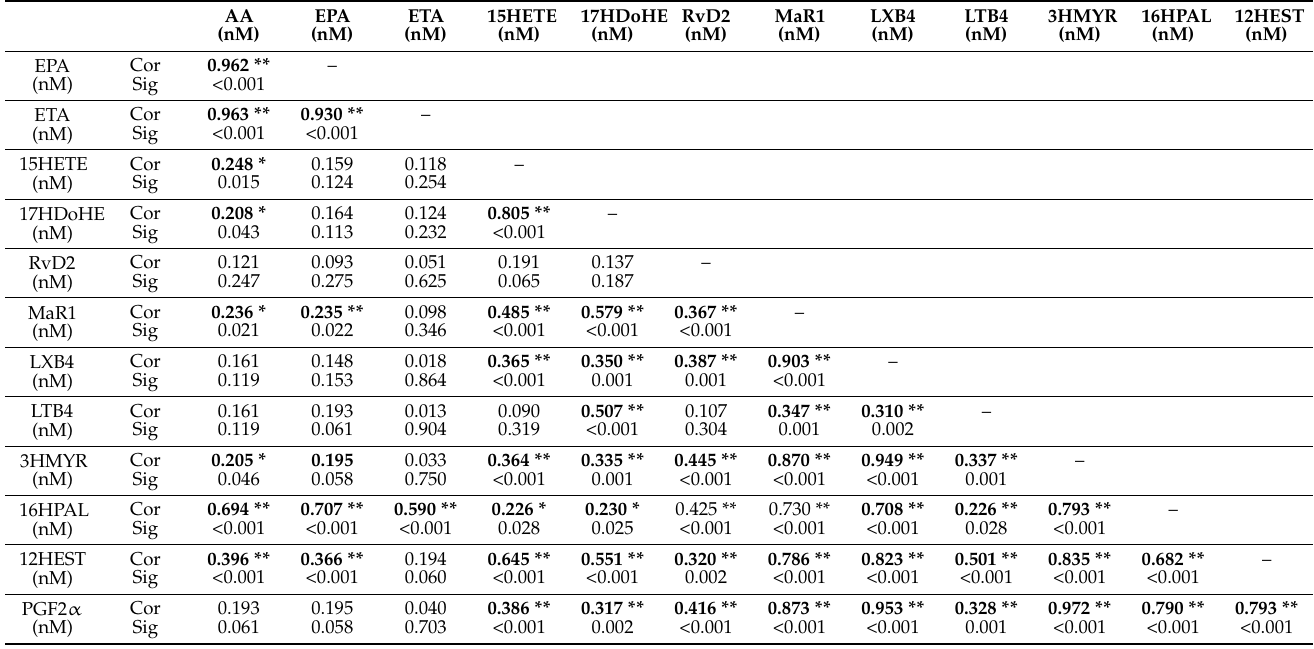
Statistical analysis: Bivariate correlation Pearson test. Cor. indicates Pearson correlation coefficient. Sig. indicates statistical significance. Bold number indicates statistically significant ** p < 0.01 and * p < 0.05. AA: